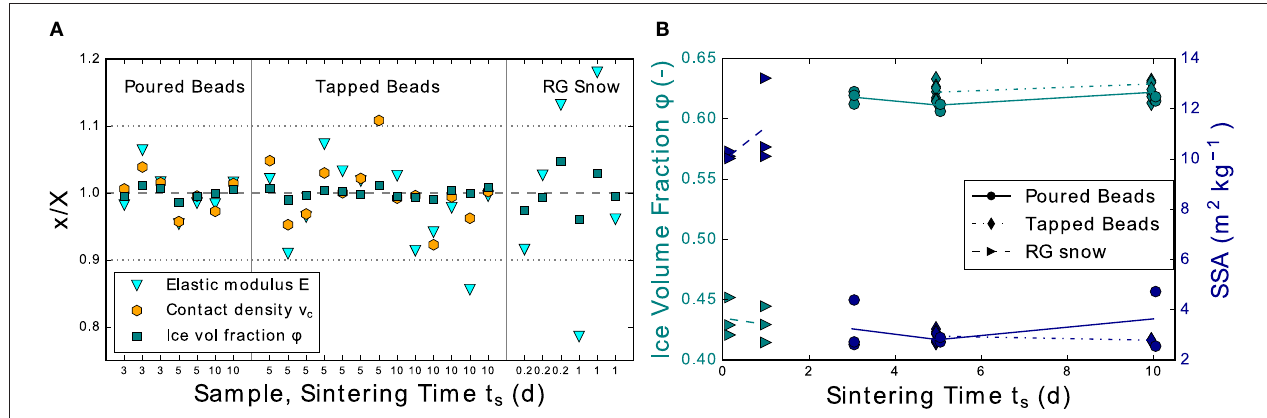
FIGURE 5 | (A) Structural parameters, x = ν c , ρ , and E normalized by the mean X of all images of one sample class are shown for all samples of the poured (left) and the tapped beads (middle) and for RG snow (right). The dotted lines indicate ± 10%; the sintering time is denoted on the abscissa. (B) Ice volume fraction and SSA of all samples against the sintering time.